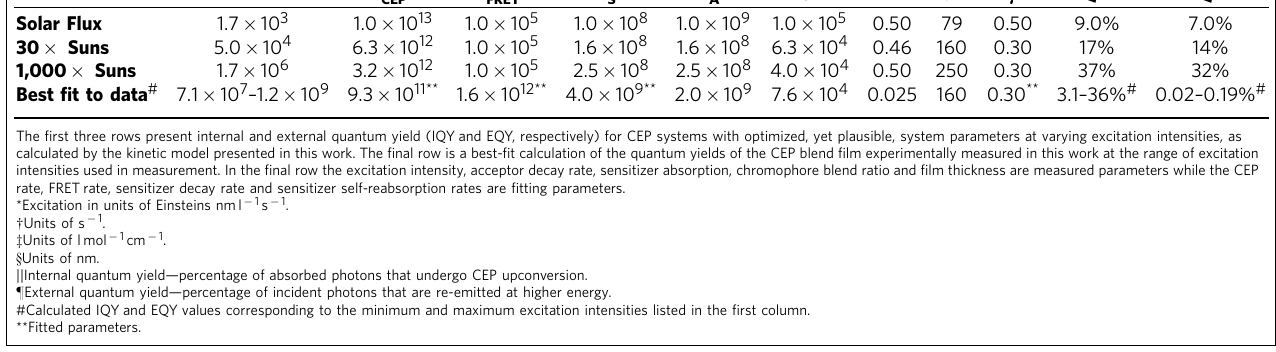
NATURE COMMUNICATIONS|8:14808|DOI: